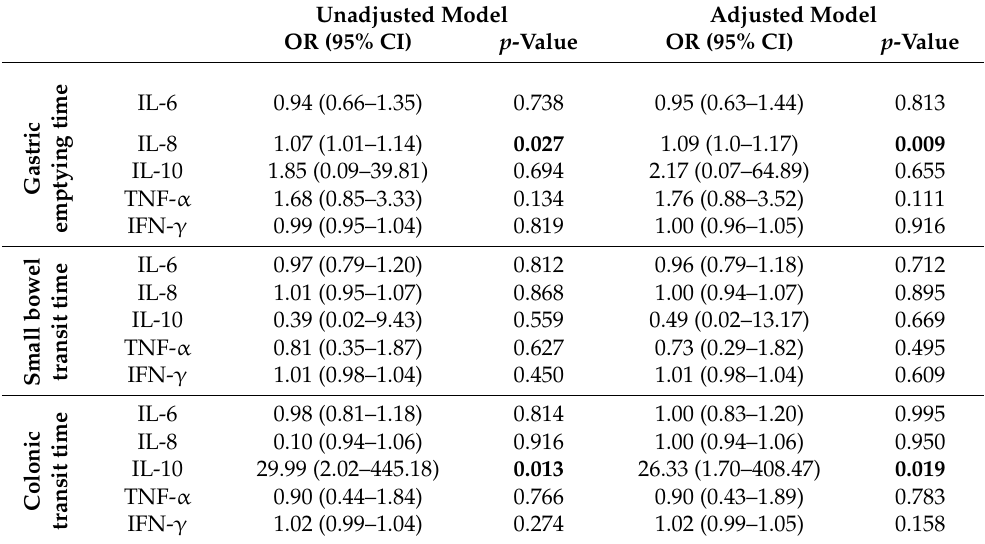
Odds ratio (OR) for associations between gastrointestinal transit times and serum concentrations of inflammatory factors in diabetes unadjusted and adjusted for disease duration and HbA1c. Boldface font indicates statistical significance ( p < 0.05).